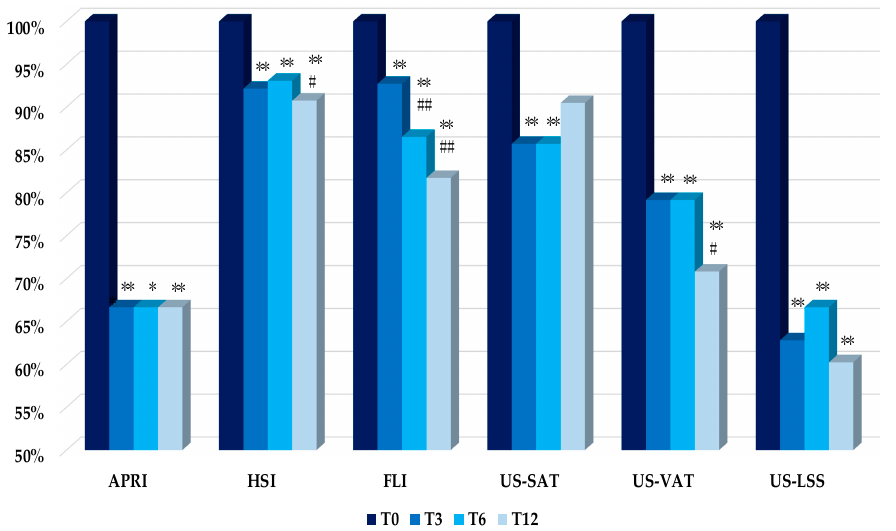
Figure 8. Mean changes, expressed as percentage changes from T0, in biometrical indices of hepatic fibrosis (APRI) and steatosis (HSI, FLI), and US parameters (US-SAT, VAT, and LSS) over the follow-up (T0, T3, T6, T12). Variation versus T0: * p < 0.05; ** p < 0.01. Variation versus previous time: # p < 0.05; ## p < 0.01. Abbreviations: APRI: Aspartate aminotransferase to Platelet Ratio Index; HSI: Hepatic Steatosis Index; FLI: Fatty Liver Index; US: ultrasound; SAT: Subcutaneous Adipose Tissue; VAT: Visceral Adipose Tissue; LSS: Liver Steatosis